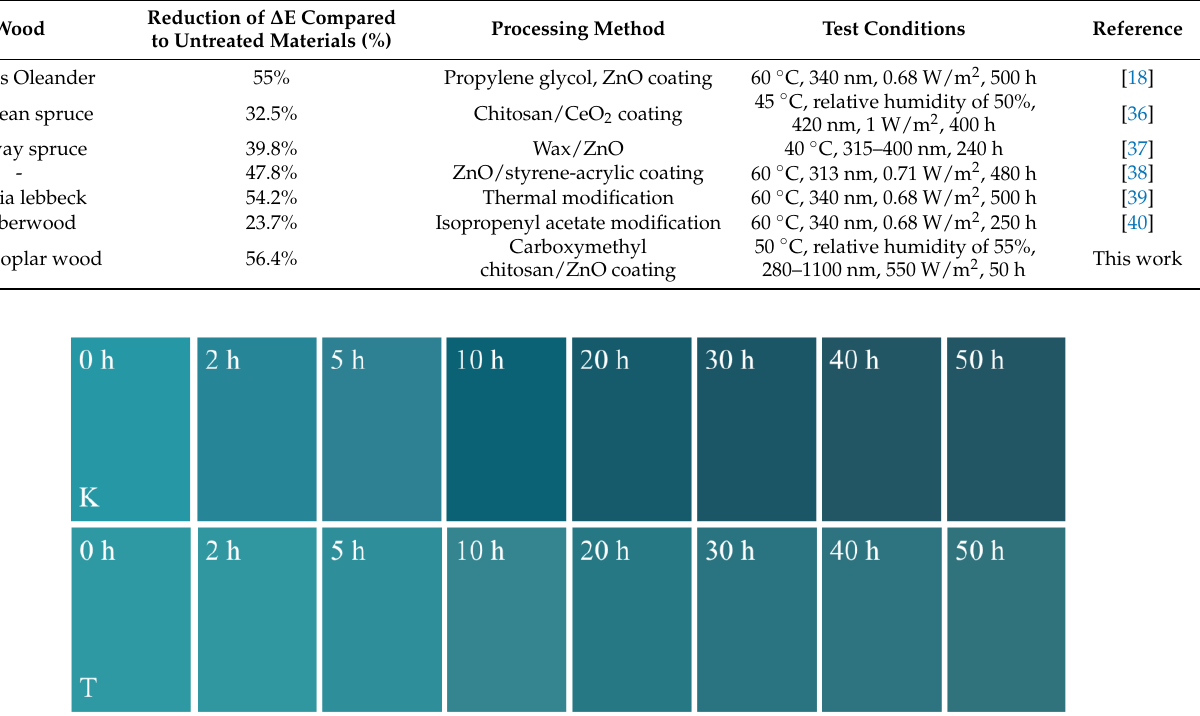
Table 2. Comparison of ∆ E changes after irradiation for treated dyed wood with other woods.